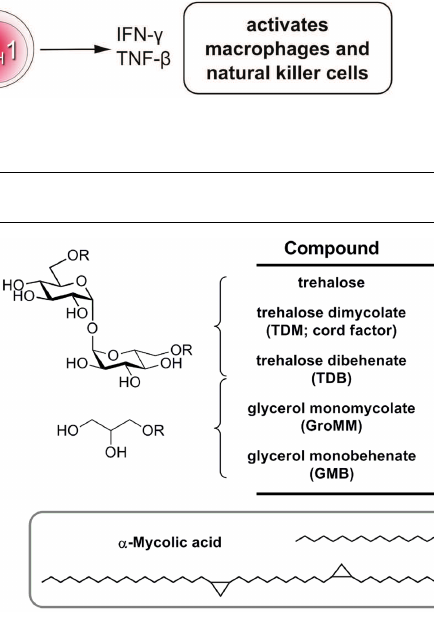
FIGURE 4 | Mycobacterial mycolic acid-based lipids and synthetic analogs (TDB and GMB), structurally defined glycolipid ligands for MCL and Mincle